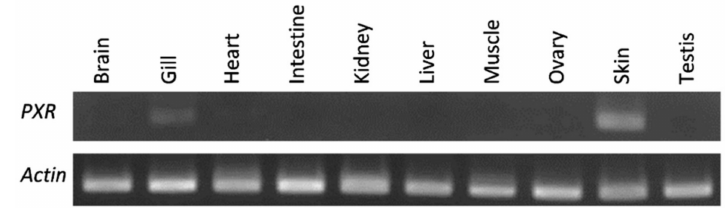
Figure 3. PXR expression pattern on an elephant shark tissue panel.